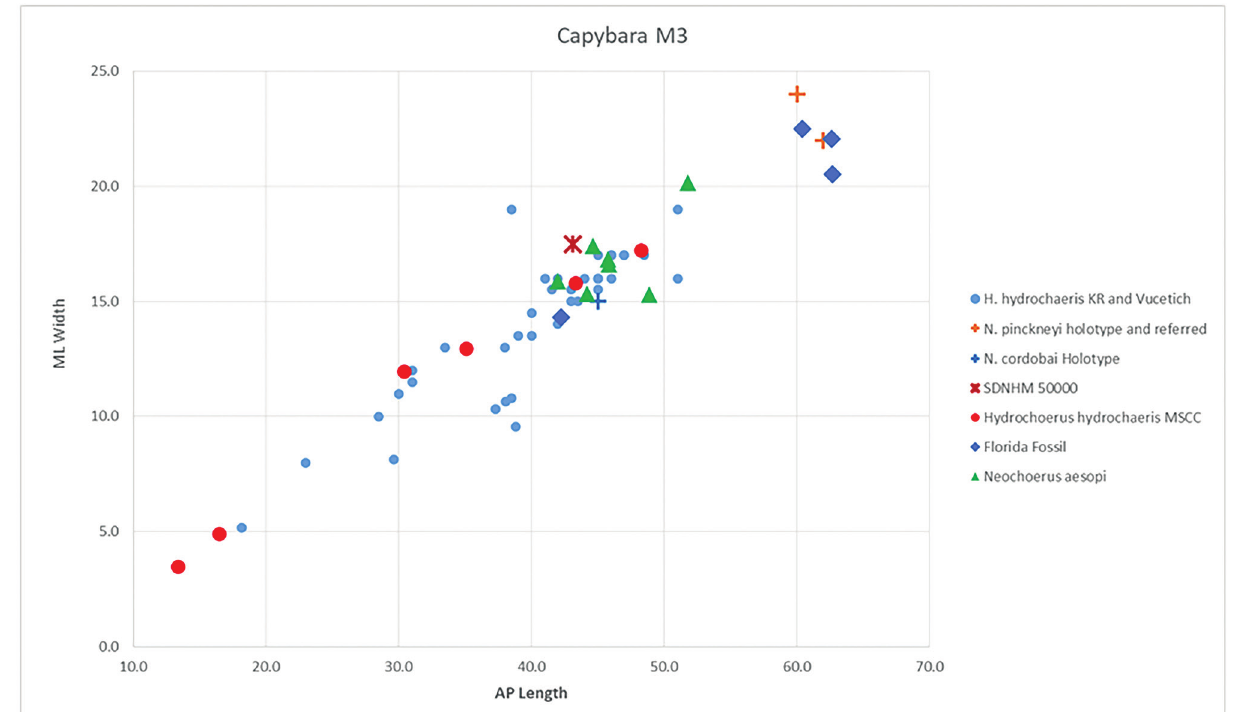
Figure 11. Bivariate plot of M3 measurements of capybaras.